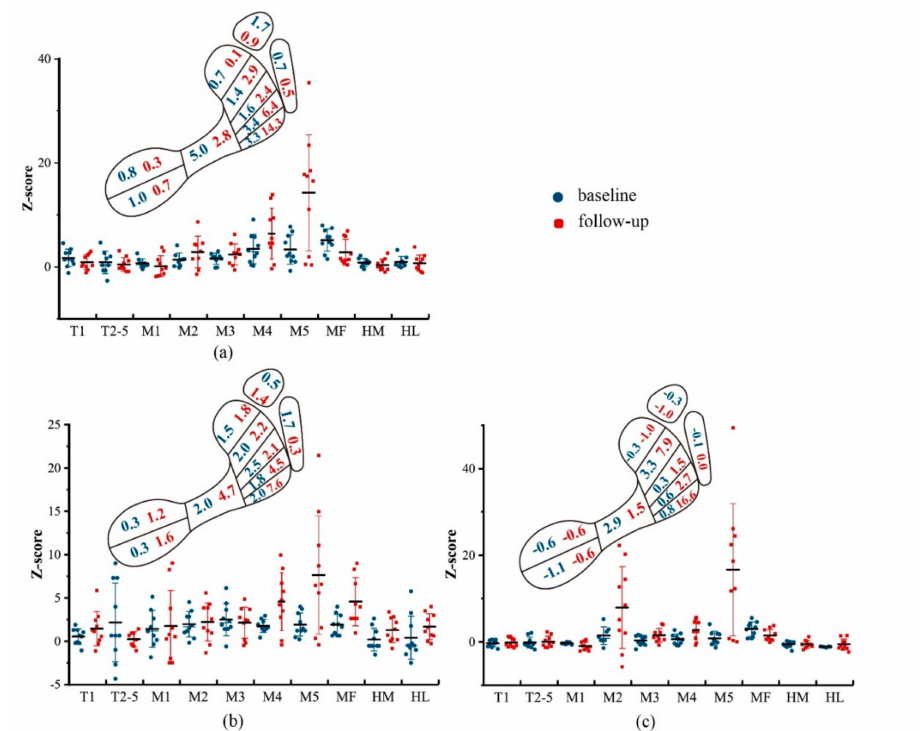
Figure 1. Mean values of z-scores of plantar pressures (( a ) peak pressure; ( b ) pressure-time integral; ( c ) standard maximum force) for obese children at baseline and follow-up. Blue numbers in the footprint represented the mean value of z-scores at baseline, and red numbers in the footprint represented the mean value of z-scores at